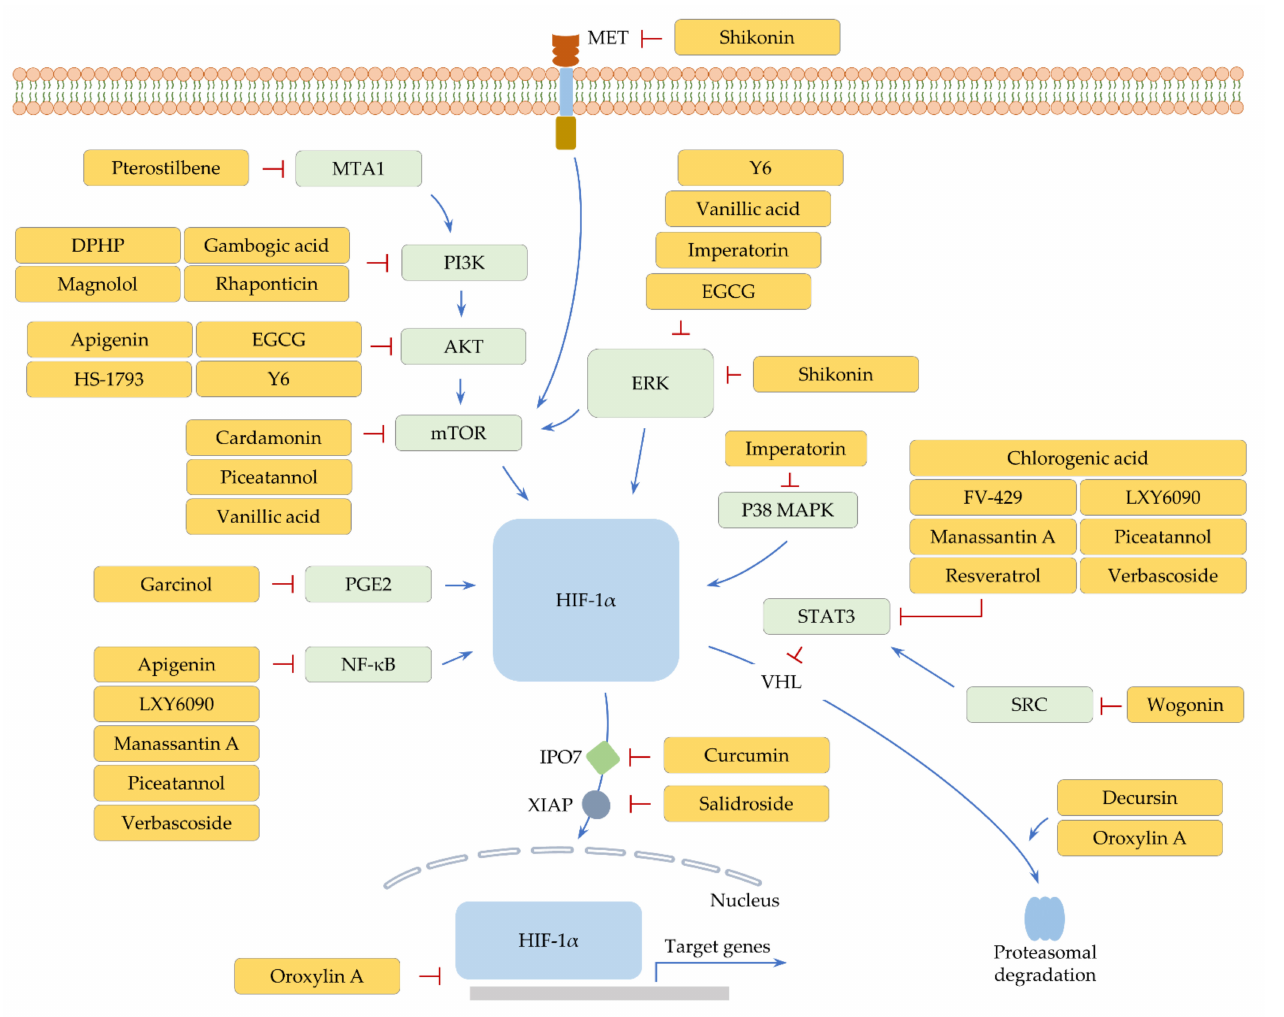
Figure 2. Polyphenol-mediated cellular signaling pathways that are anticipated to regulate HIF-1 α . Positive regulation is pointed out by arrow lines (blue). A restrictive action is indicated by perpendicular lines